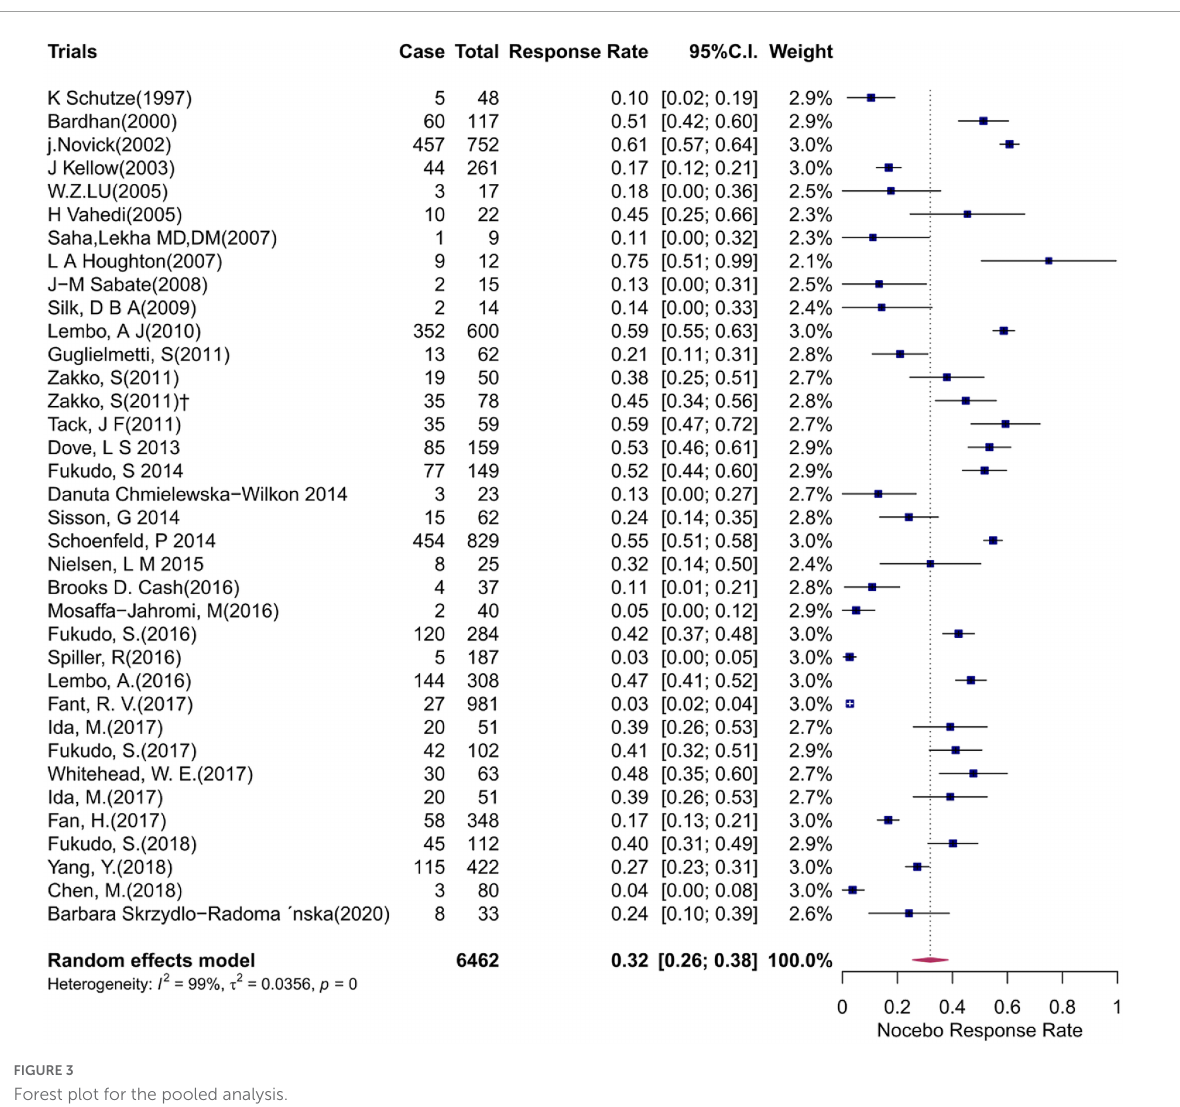
FIGURE3 Forest plot for the pooled